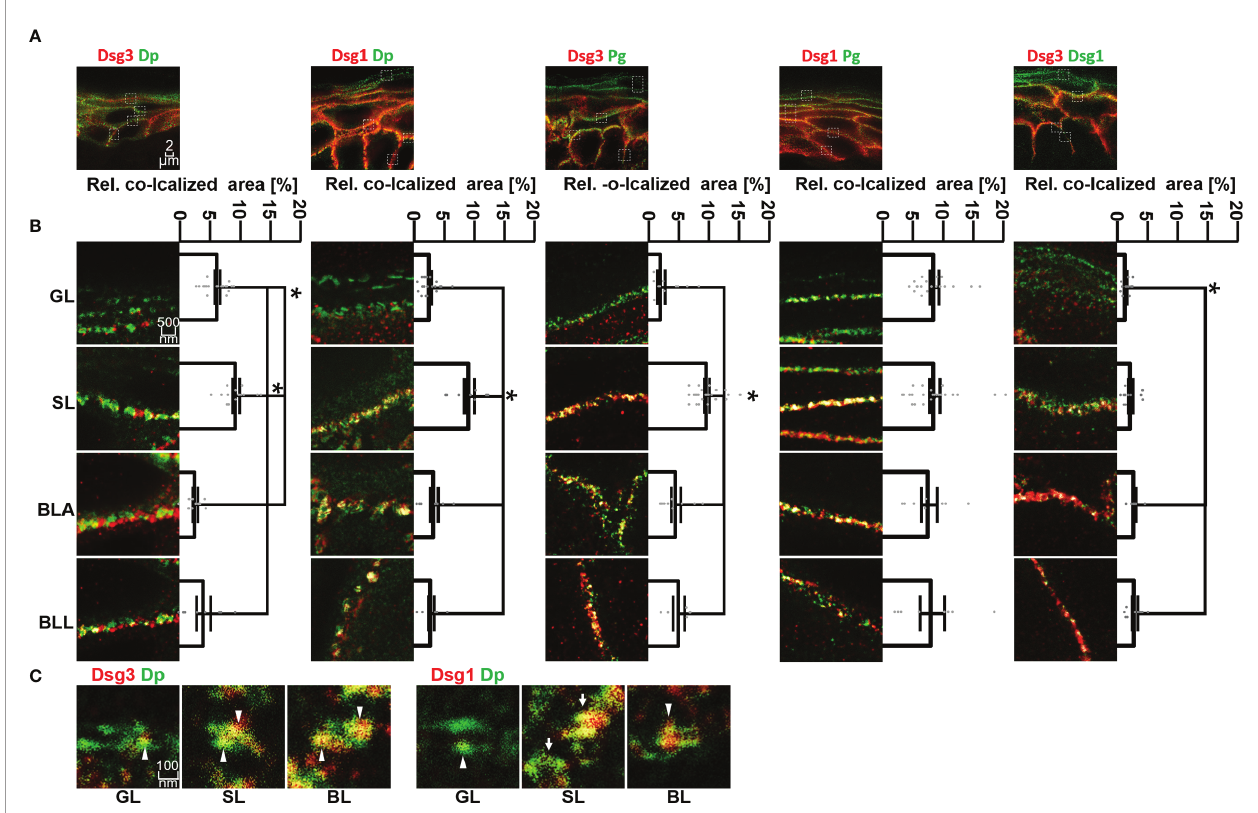
FIGURE 3 | (A) Confocal microscopy images of co-stainings of Dsg3 or Dsg1 (red) with Dp, Pg or Dsg1 (green). (B) STED microscopy images of zoom to single cell border of the different epidermal layers. Shown to the right are quanti fi cations of the co-localization of the two stained proteins. (C) STED microscopy images of co- stainings of Dsg3 or Dsg1 (red) with Dp (green) in human skin samples, sowing a resolution on a single desmosome scale. White pointers domains containing only either Dsg1 or Dsg3, white arrows whole desmosomes, containing almost only Dsg1 or Dsg3. N (body donors)=5, n (cell borders)=2-6. *Signi fi cant difference to the value which is indicated that it is compared